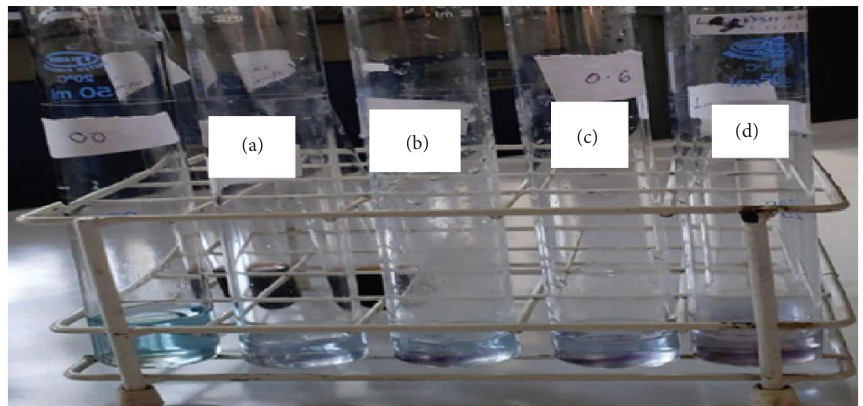
Figure 4: Biuret test for KH extract (a) 95 ° C, 1N & 1.5hr (b) 65 ° C, 1N and 3.5hr (c) 80 ° C, 0.5N and 1.5 hr (d) 80 ° C, 0.5 N and